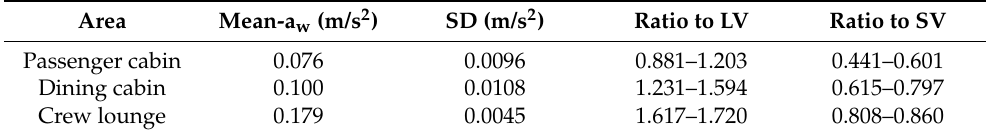
Table 3. Statistical parameters of vibration for analysis in different measurement areas.